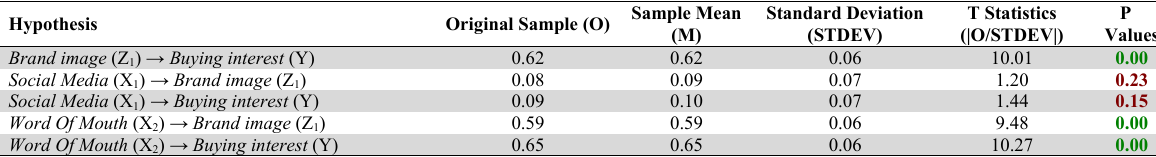
T-statistics and P-Values Effect of Total